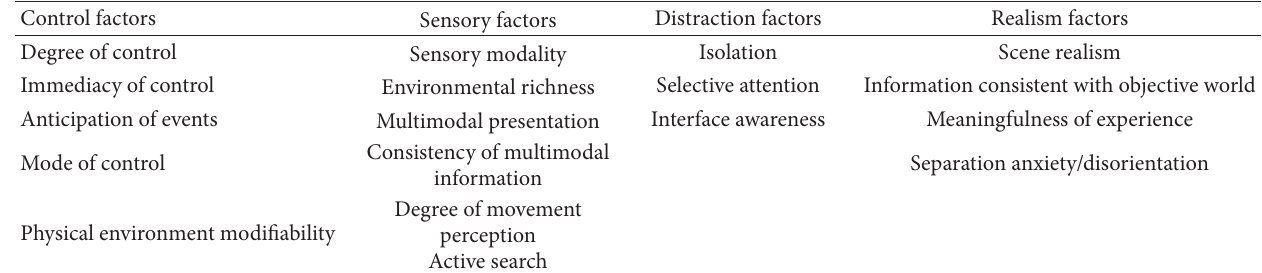
Table 1: Factors hypothesized to contribute a sense of presence [19].